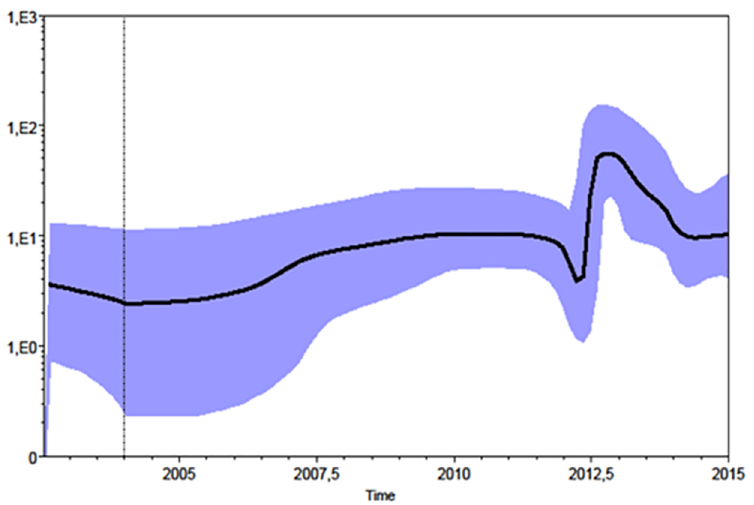
Fig 3. Population dynamics analysis of the European monophyletic clade of WNV-2. Bayesianskyline plot (BSP). The effective numberof infectionsis indicatedon the Y axis, and time on the X-axis. The coloured area corresponds to the credibility interval basedon the 95% highestposterior density interval